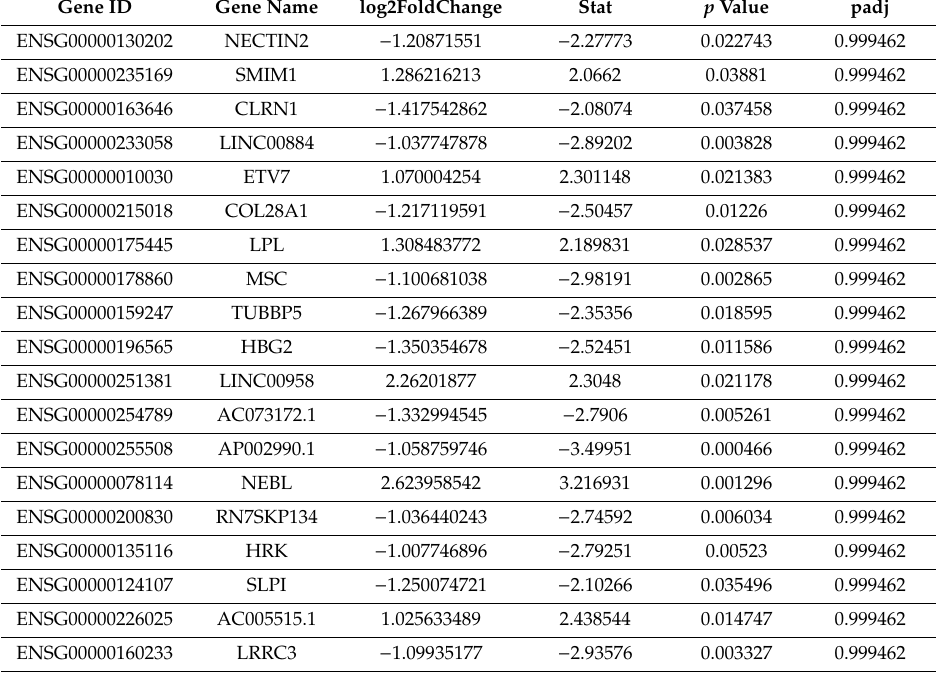
Table 3. Di ff erent expressed genes between HD gene carrier with depression and HD gene carrier without depression.